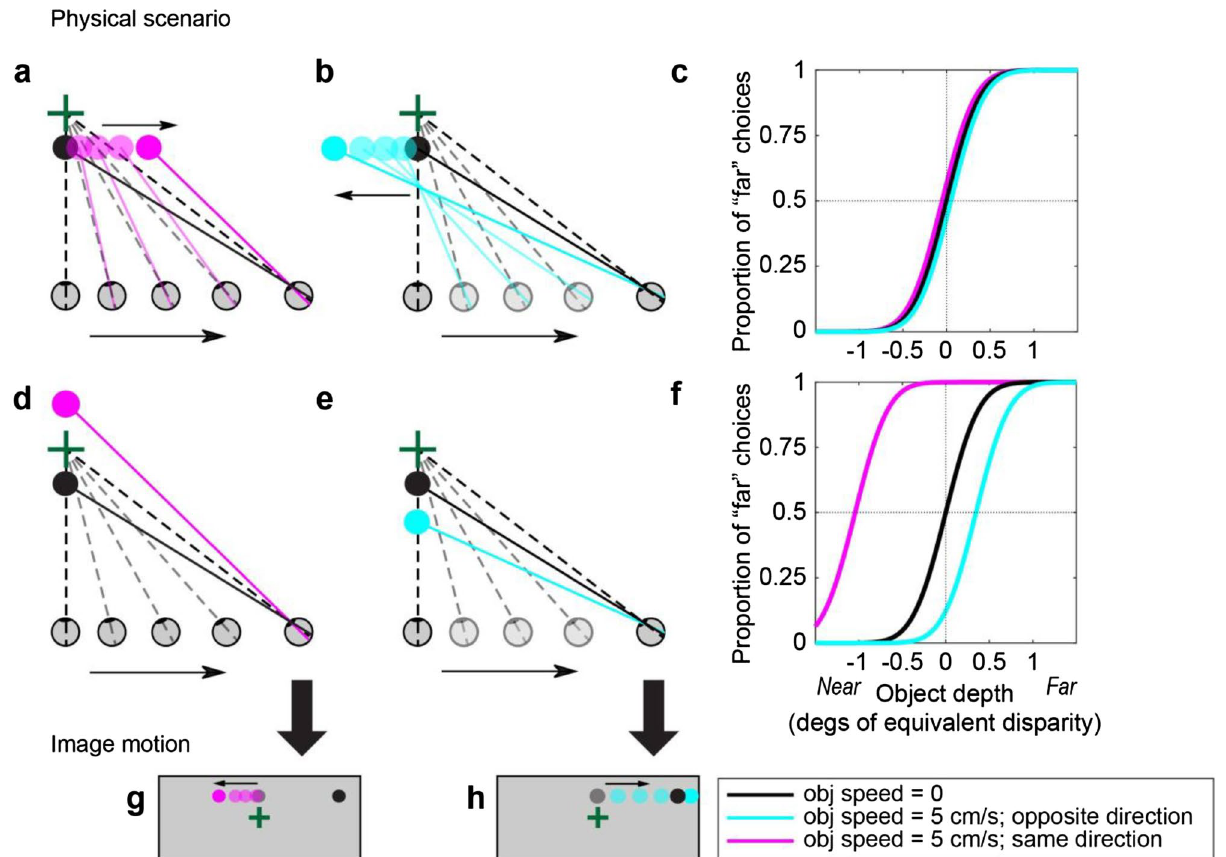
Figure 2. Predicted behavioral results under two hypotheses. ( a ) Example physical scenario in which an object (magenta circles) and the observer’s eye are translating in the same direction (rightward). As the observer translates, they counter-rotate their eye to maintain fixation on a world-fixed point (green cross). The black circle shows the location of the object if it is stationary in the world (obj speed = 0). ( b ) Example scenario in which the object (cyan circles) and self are moving in opposite directions. ( c ) Predicted depth psychometric curves if an observer can accurately parse retinal image motion into components related to object motion and self-motion, and use the latter to compute depth via the motion-pursuit law. Note that depth is expressed in units of equivalent binocular disparity (see text). ( d ) Physical scenario in which a stationary object at a far depth produces the same image motion as in panel ( a ). ( e ) Physical scenario in which a stationary near object creates the same image motion as in panel ( b ). ( f ) Predicted depth psychometric curves if an observer computes depth, via the motion-pursuit law, based on net image motion. Note that the magnitude of the perceptual bias, in degrees of equivalent disparity, is smaller when the object moves in the direction opposite to self-motion (cyan curve). This is due to the nonlinear relationship between depth measured in metric distance versus equivalent disparities. ( g ) Image motion corresponding to panels ( a ) and ( d ). ( h ) Image motion corresponding to panels ( b ) and ( e